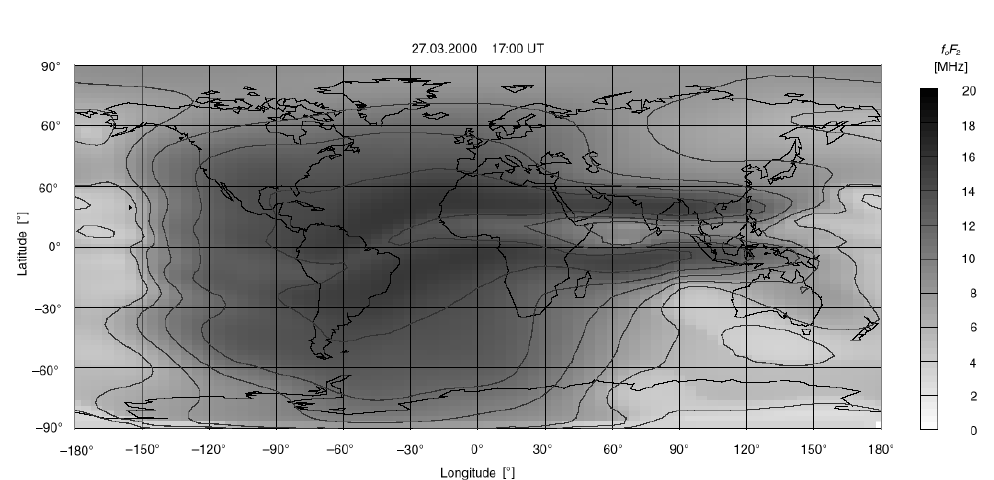
Fig. 5. Measured and reconstructed f o F 2 using NeQuick model driven by Az grids derived from La Plata vertical TEC maps for the day 27 March 2000. The best fit-line is also indicated.